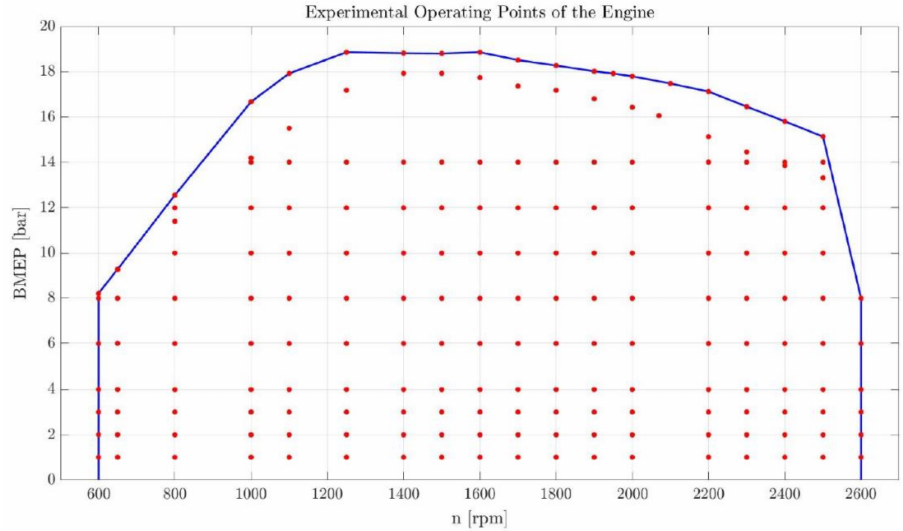
Figure 2. 210 kW (red points) and 235 kW (blue circles) engine operating maps (BMEP as function of engine